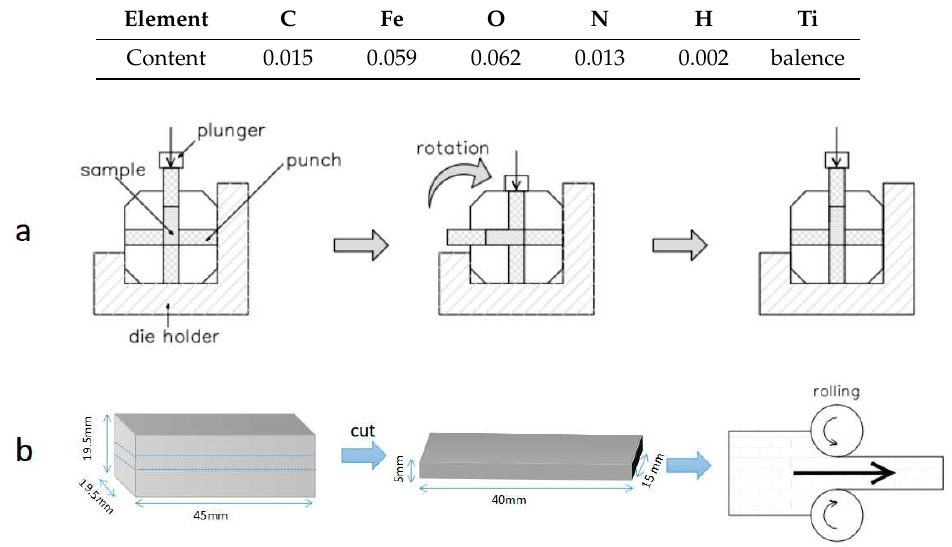
Table 1. Analyzed composition of commercially pure titanium in this paper (wt %).